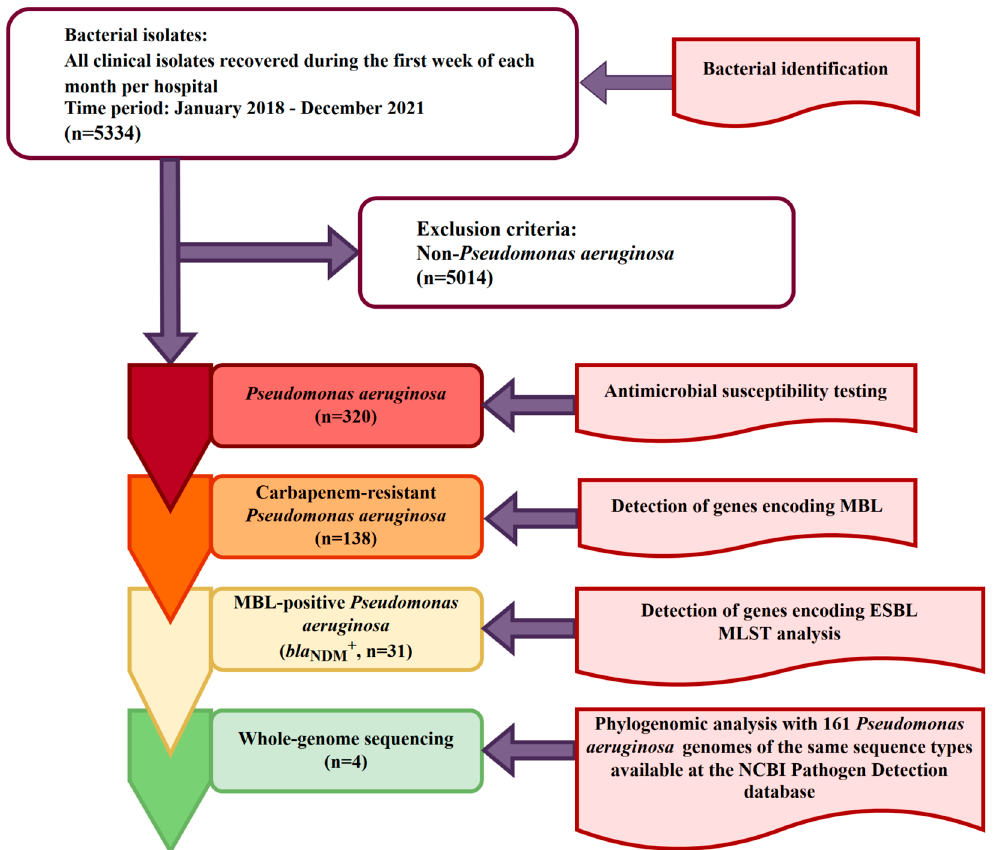
Figure 6. Flowchart of the process of bacterial isolates selection for phenotypic and genotypic characterization; inclusion criteria was the isolation of the Pseudomonas aeruginosa from non-redundant clinical samples (one per infected patient) obtained during the routine laboratory work. MBL—Metallo- β -lactamase; ESBL—Extended-spectrum beta-lactamase; MLST—Multilocus sequence typing.